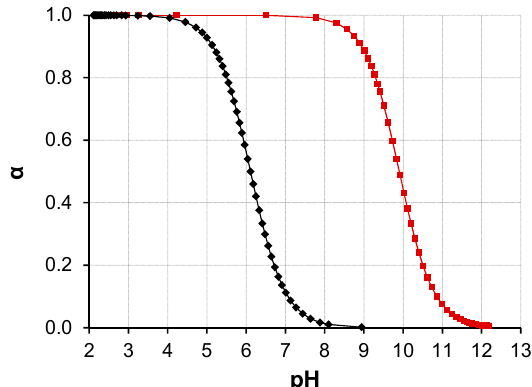
Figure 9. Degree of protonation ( α ) of PDMAEMA (10 mM of repeating units, 1.57 g/L, black diamonds ♦ ) and silicate (initially SiO 32 − from a 10 mM solution of SS, which undergoes hydrolysis to yield SA, red squares ■ ) solutions as a function of pH, as determined by titration. The pKa (PDMAEMA) = 6.1 and pKa (SA) = 9.9.